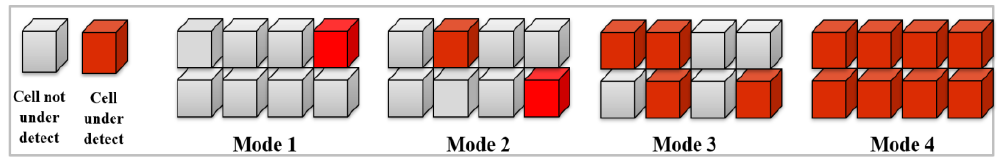
Figure 8. Four Detection Modes.